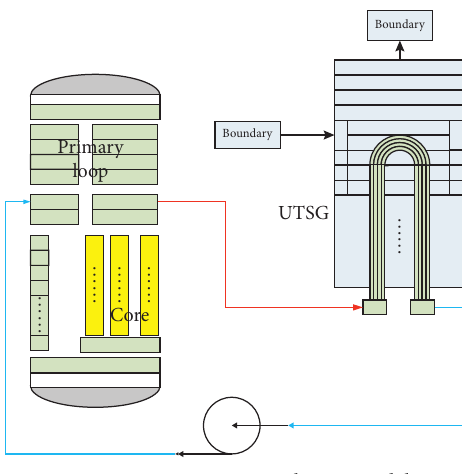
Figure 4: CPR1000 simulation model.